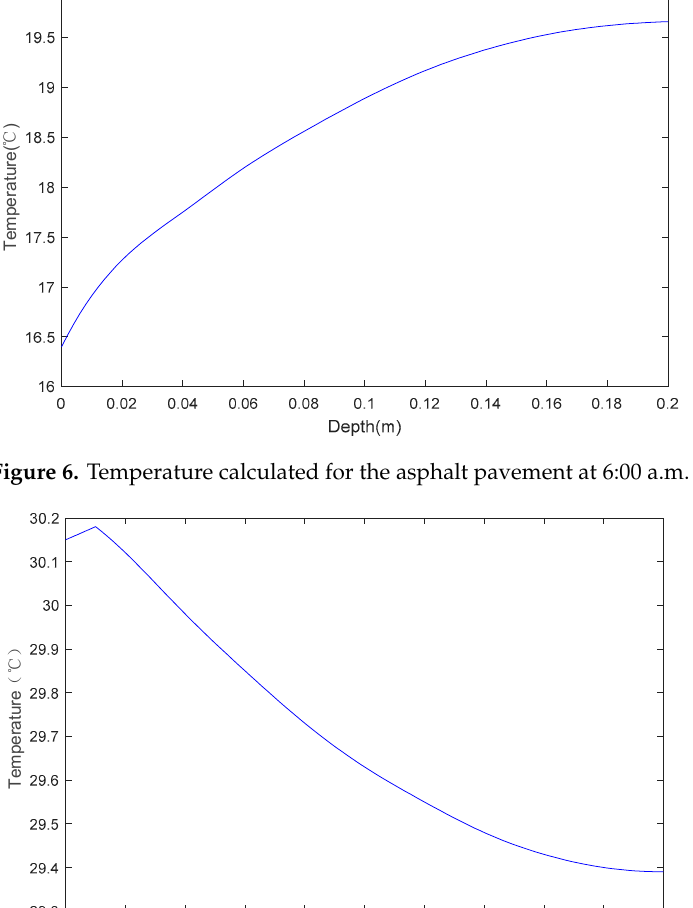
Figure 6. Temperature calculated for the asphalt pavement at 6:00 a.m.